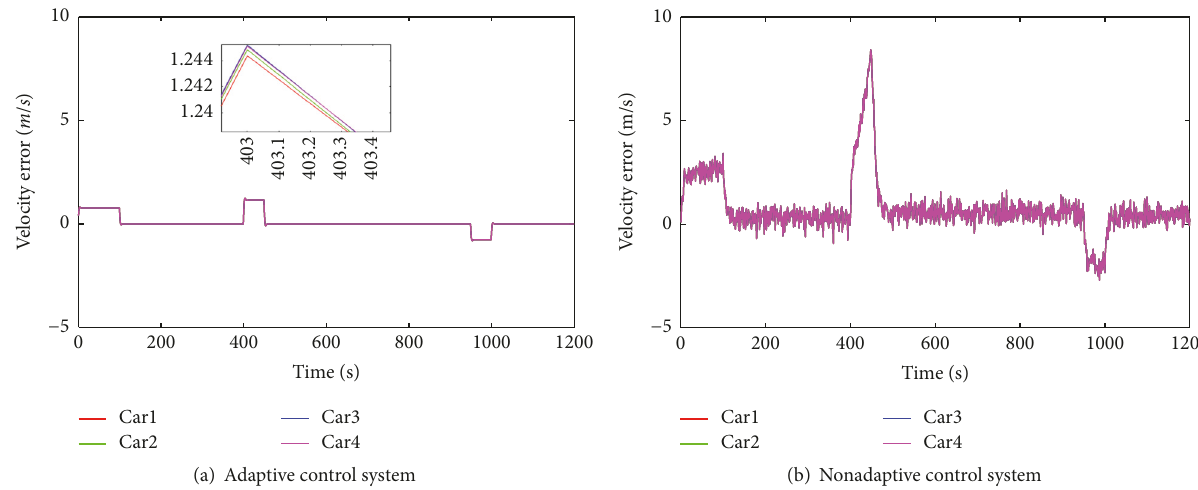
Figure 9: Comparison of adaptive control system with nonadaptive control system in predicted output velocity and the desired velocity error.